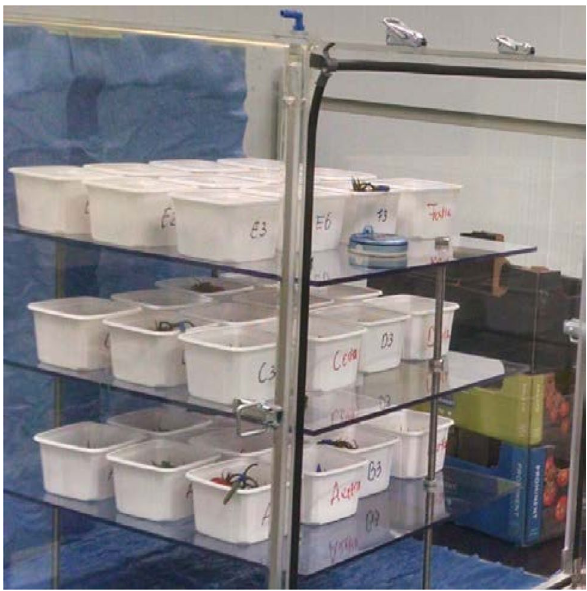
Figure 2. A controlled environment which is ideal for fungal germination.